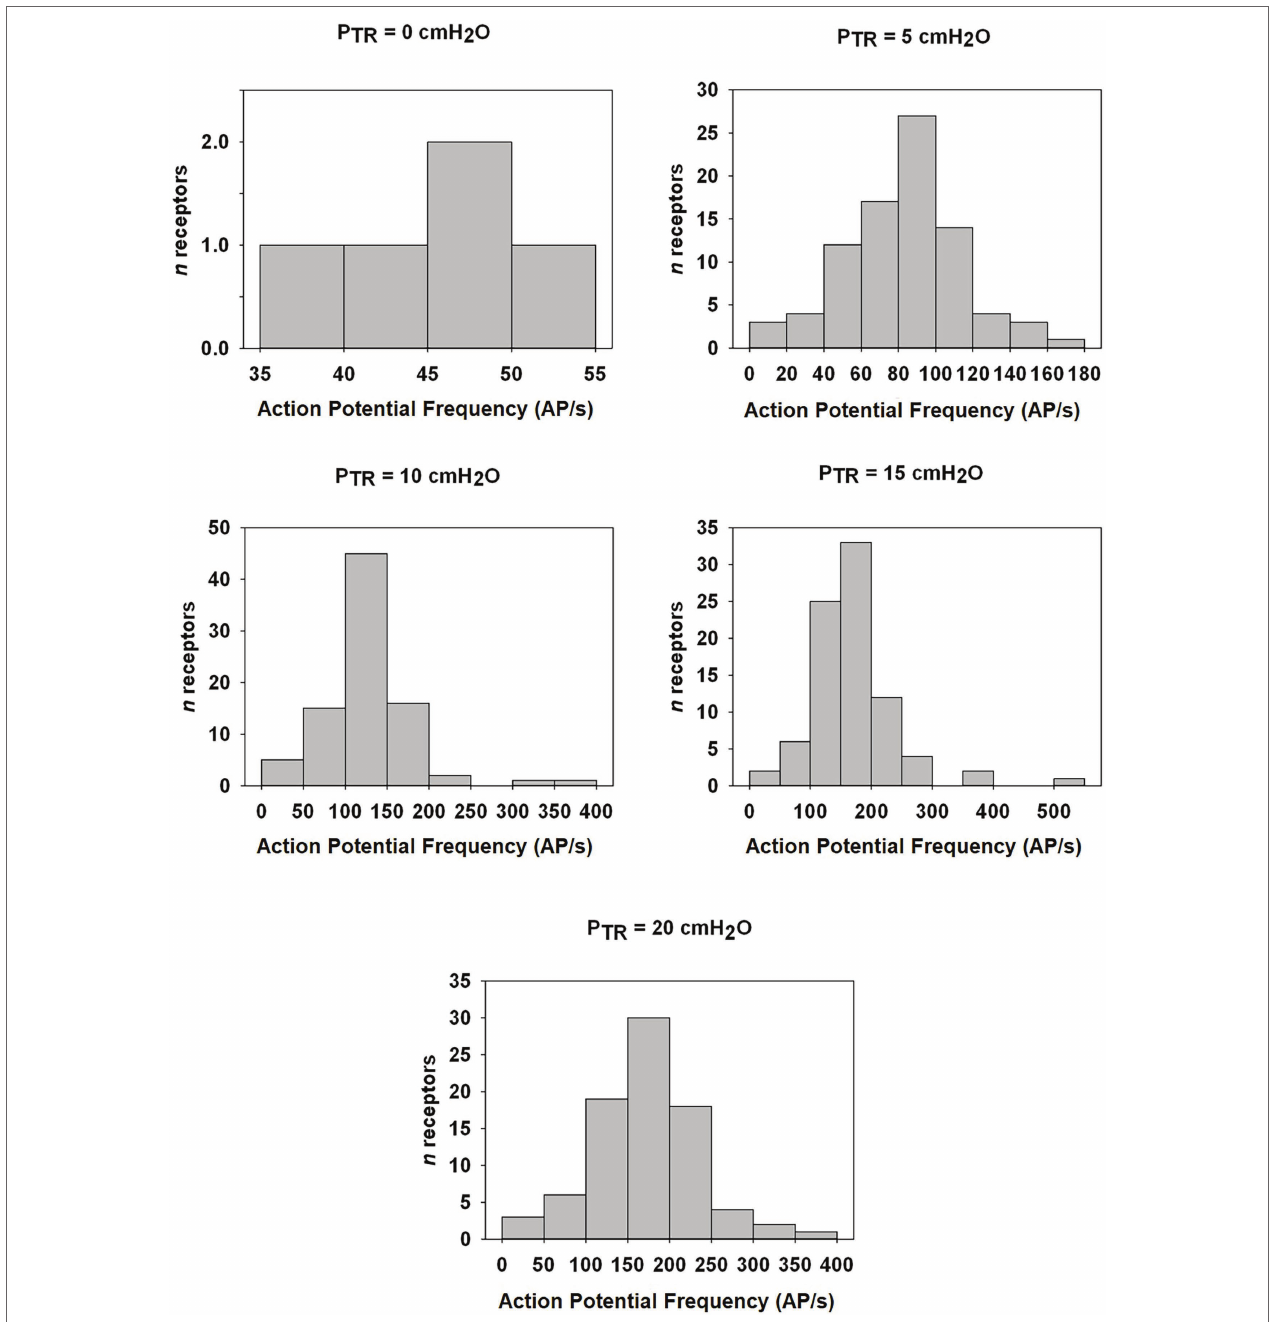
FIGURE 7 | Distribution histogram of Action Potential frequency (AP f ) among murine SARs at indicated P TR from FRC (0 cmH 2 O) to TLC (20 cmH 2 O). The number of fibers and the AP f in AP/s is indicated for static pressures of 0, 5, 10, 15, and 20 cmH 2 O. Note the change in Y-axis ranges between